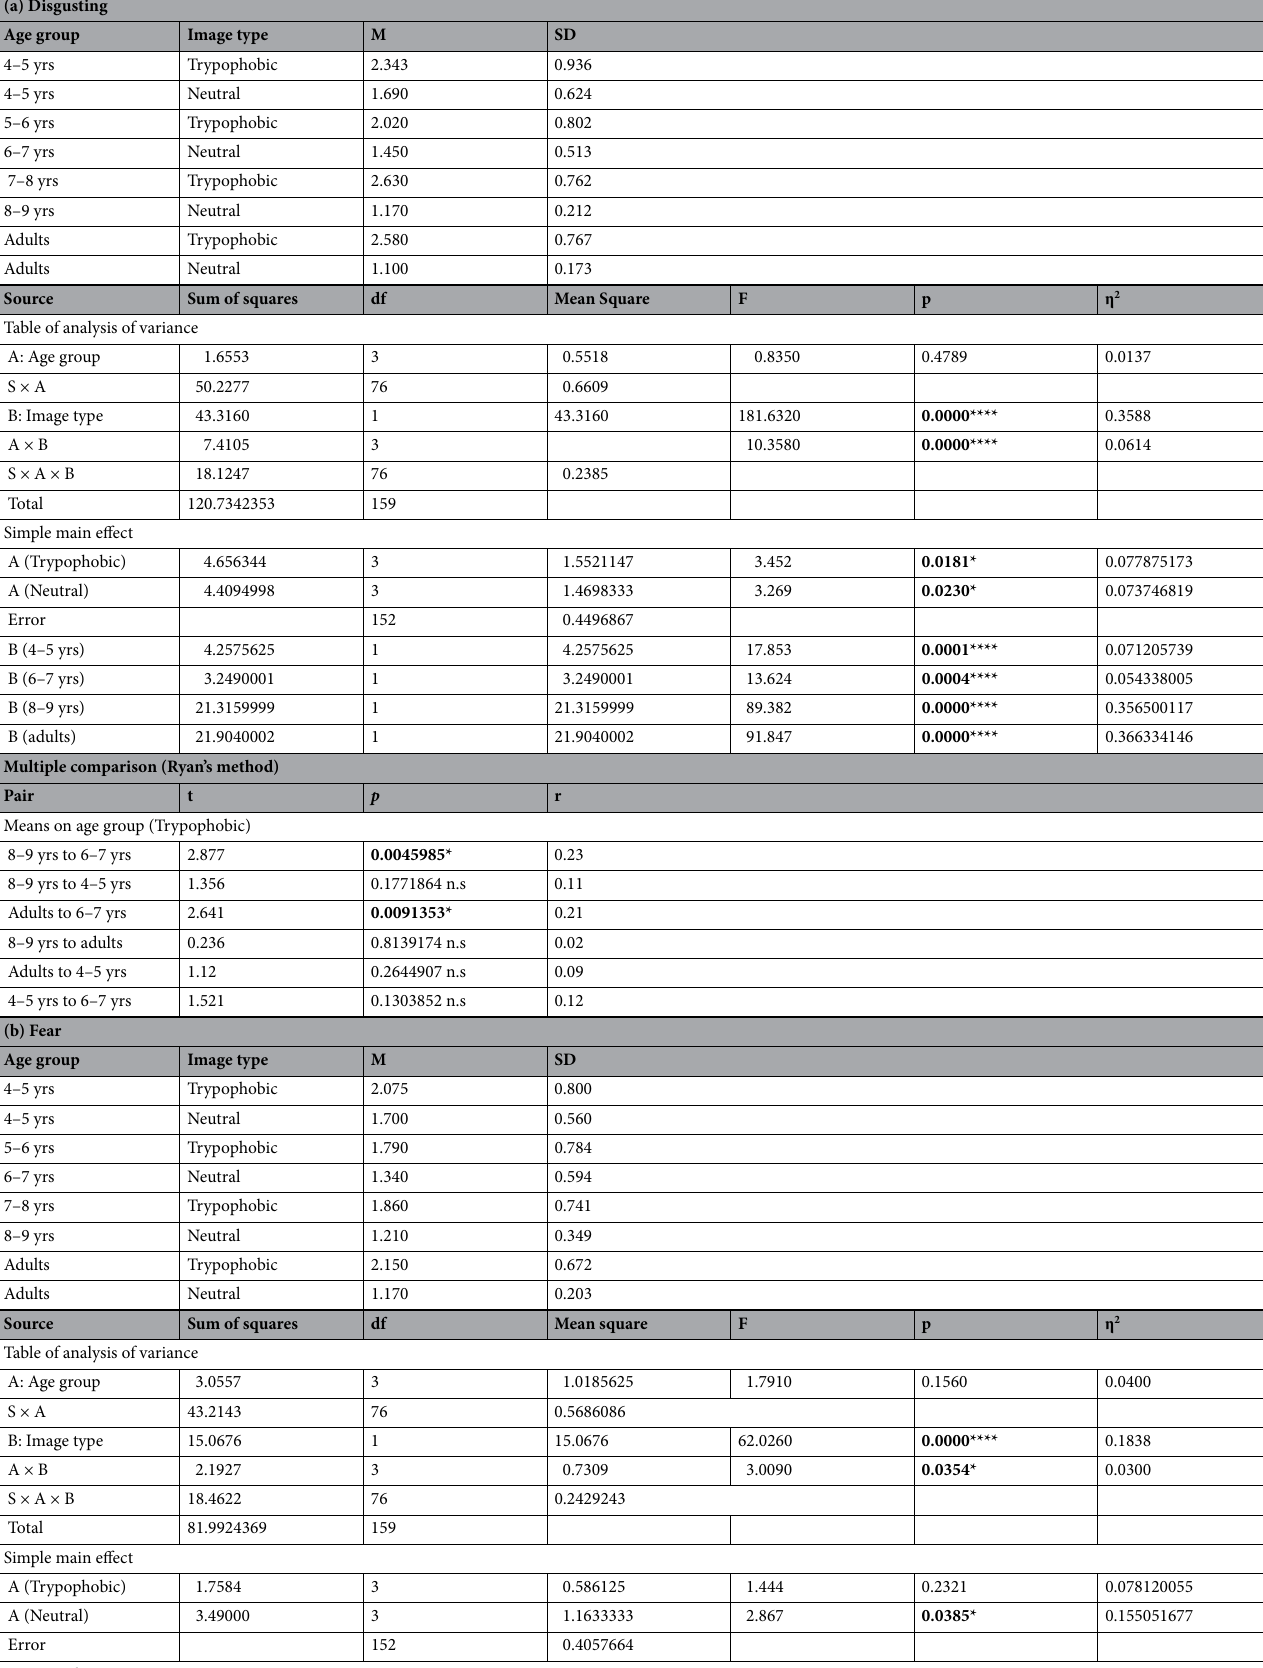
Table of analysis of